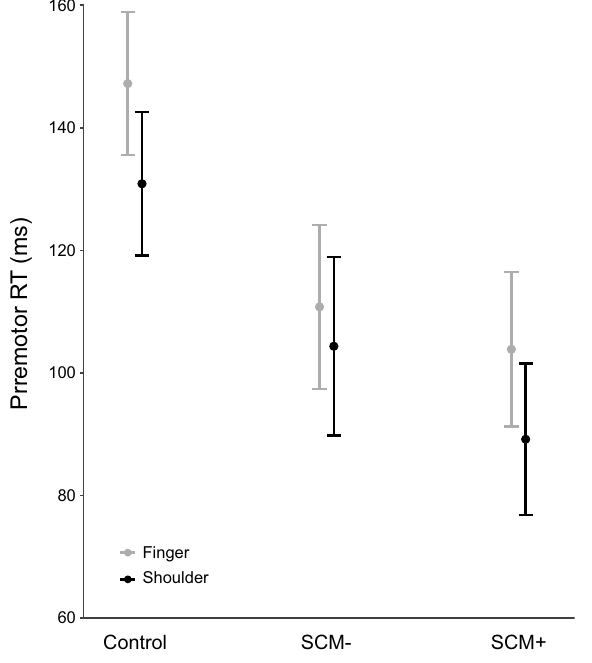
Figure 1. Premotor reaction time (RT; ms) shown for control trials, and startle trials in which activation in the sternocleidomastoid (SCM) was either absent (SCM −) or present (SCM +). Note the analysis only involved a comparison of SCM + /− conditions (n = 890 trials), whereby a significant interaction effect (p = 0.031) was found due to a larger decrease in RT for SCM + versus SCM − trials for the shoulder versus the finger response. Error bars represent 95% CI.